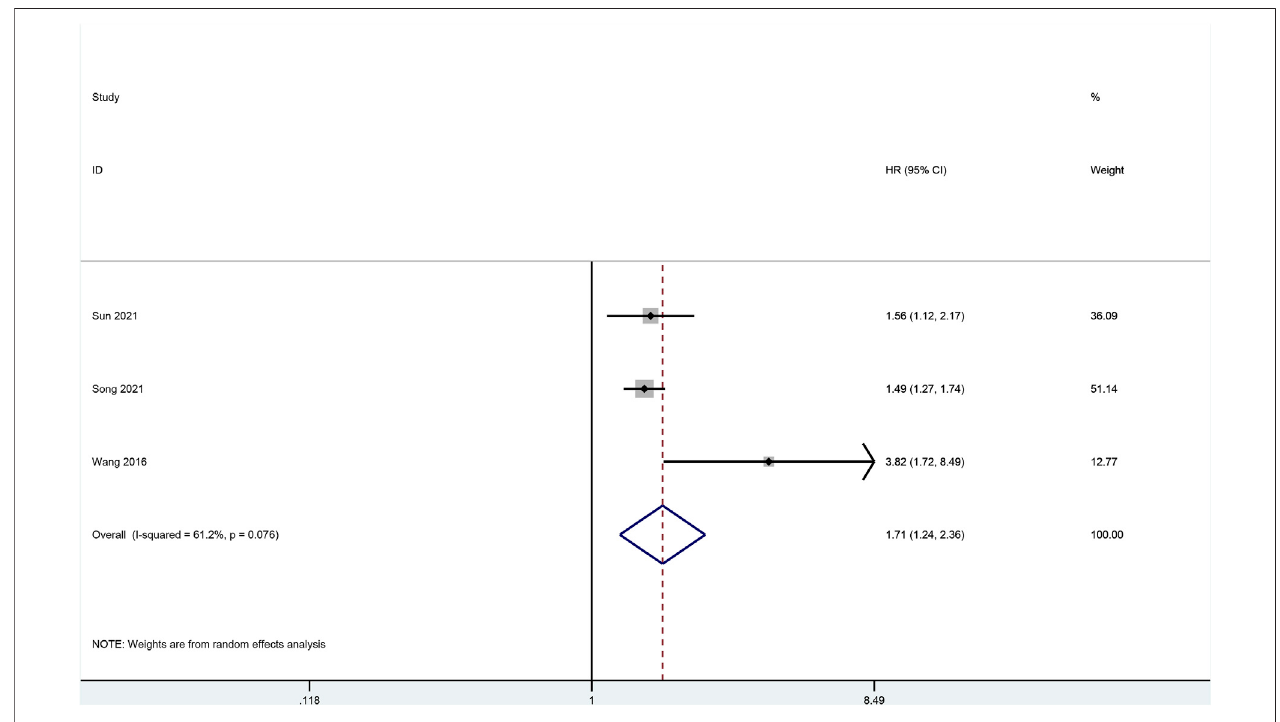
FIGURE 10 | Forrest plot of meta-analysis for CTHRC1.